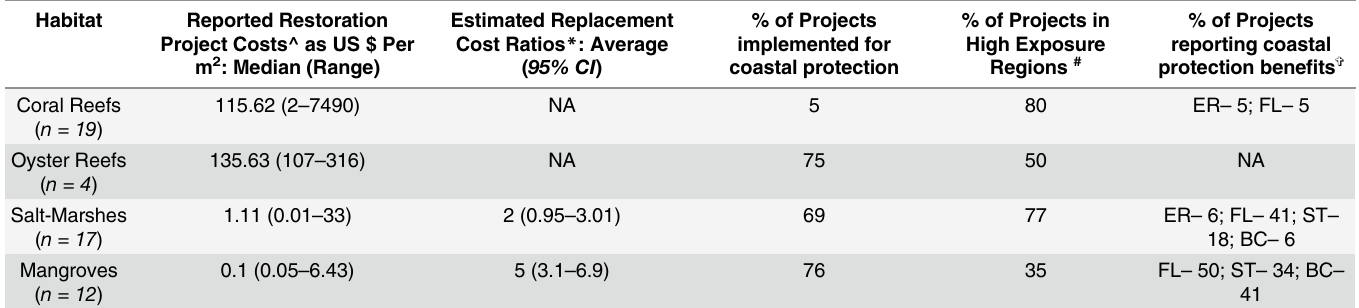
Table 1. Costs and Coastal Protection Benefits of Restoration